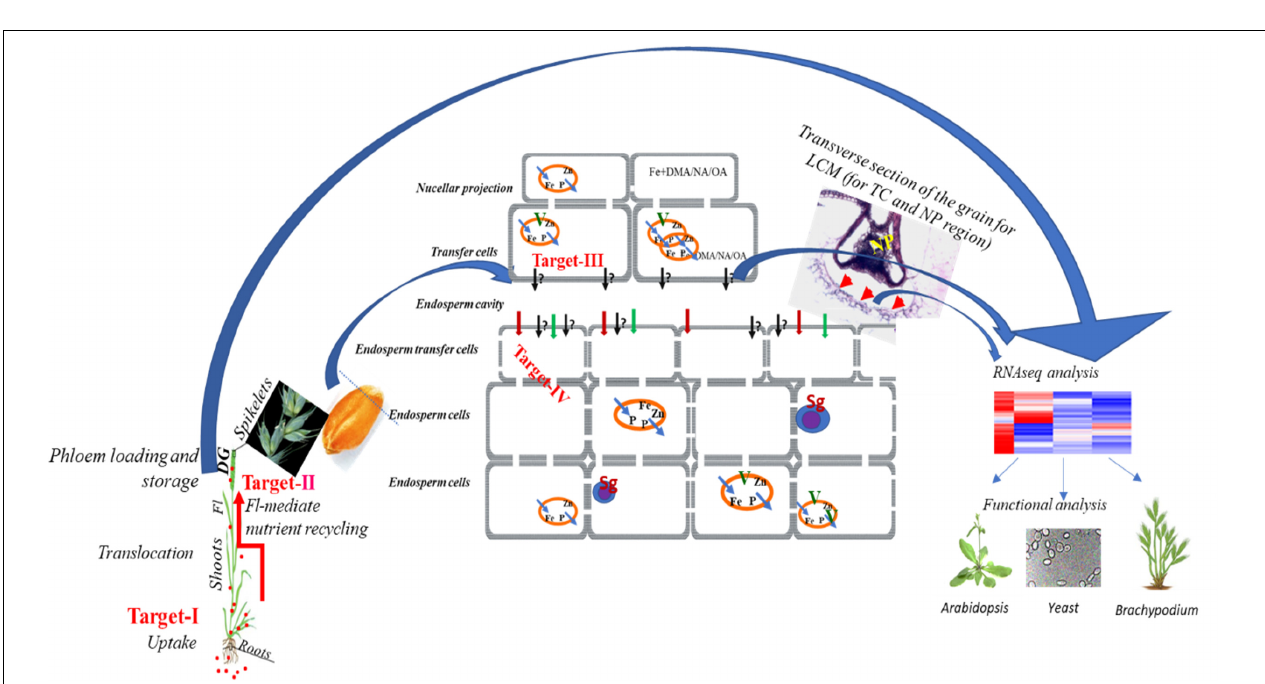
FIGURE 3 | Schematic representation of the primary bottleneck for Fe acquisition, uptake and mobilization in wheat shoot and grain. Multiple target areas have been identified to enhance the mobilization of Fe from soil to roots, from roots to shoots, and subsequently their loading in the grains through specific conducting tissue. The first is referred as Target-I, and Target-II depict the uptake of Fe in roots and then to shoots and eventually loading to the edible grains. In wheat, primarily at this stage, the bottleneck includes the transfer and mobilization of Fe from discontinued xylem to the transfer cells and subsequently to the endodermal cells (Target-III and IV). The target areas Target-III and IV remained unexplored in hexaploid wheat. The area that needs attention is to perform grain or Tissue or single cell-specific-omics approach that will help in identifying key transporters and regulators. These identified key genes could be tested for their functional validation in yeast and subsequent proof-of-function in Arabidopsis , Brachypodium, or in wheat. The red arrow indicates the process in wheat, and the blue arrow indicates the means to further characterize wheat genes in different model species.